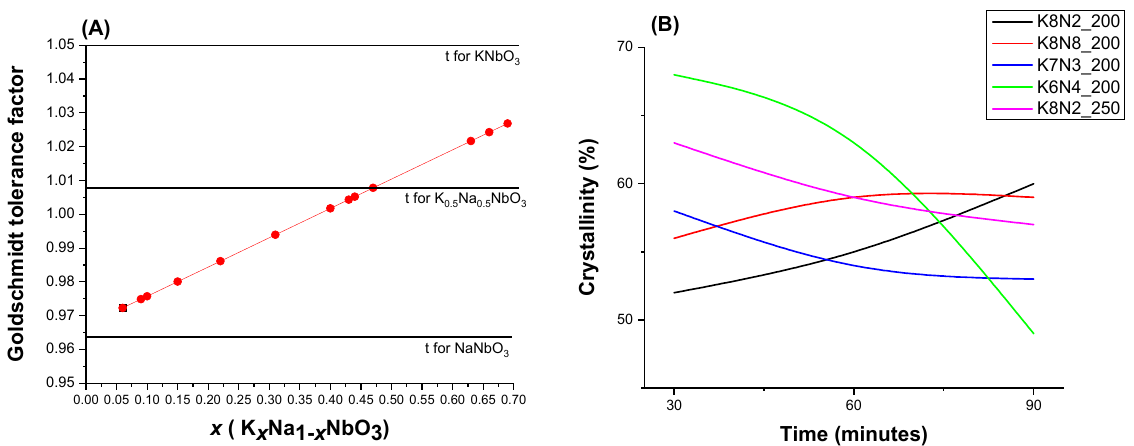
Figure 4. Unit cell relative volume variation depends on dwelling time ( A ) and temperature ( B ) of HTMW treatment for series of samples: K8N8, K8N2, K7N3 and K6N4.